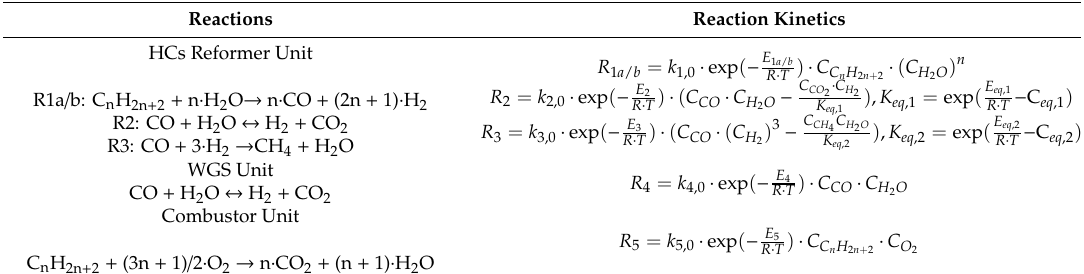
Table 1. Reactions taking place at the coupled reforming / combustor